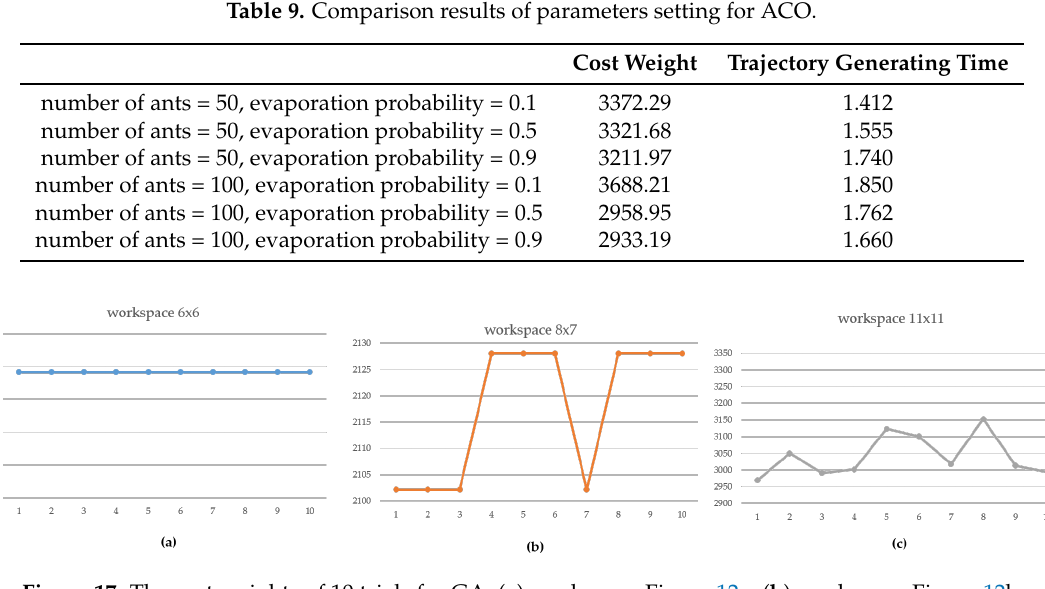
Figure 17. The cost weights of 10 trials for GA. ( a ) workspace Figure 12a, ( b ) workspace Figure 12b, ( c ) workspace Figure 12c.